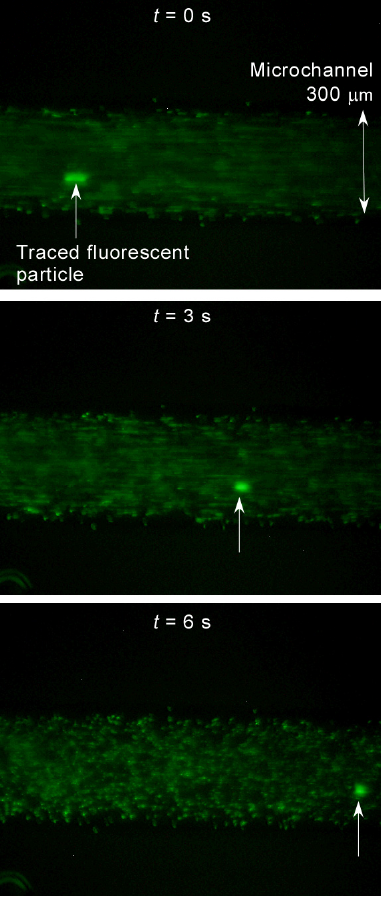
Figure 3. Pump demonstration using a circular microchannel by fluorescent microscopic pictures in a microchannel at t = 0 s (starting), 3 s, and 6 s. Green points indicate fluorescent